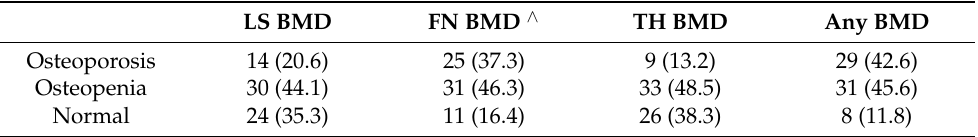
Table 2. Classification of bone health using BMD. LS BMD FN BMD ∧ TH BMD Any BMD Osteoporosis Normal